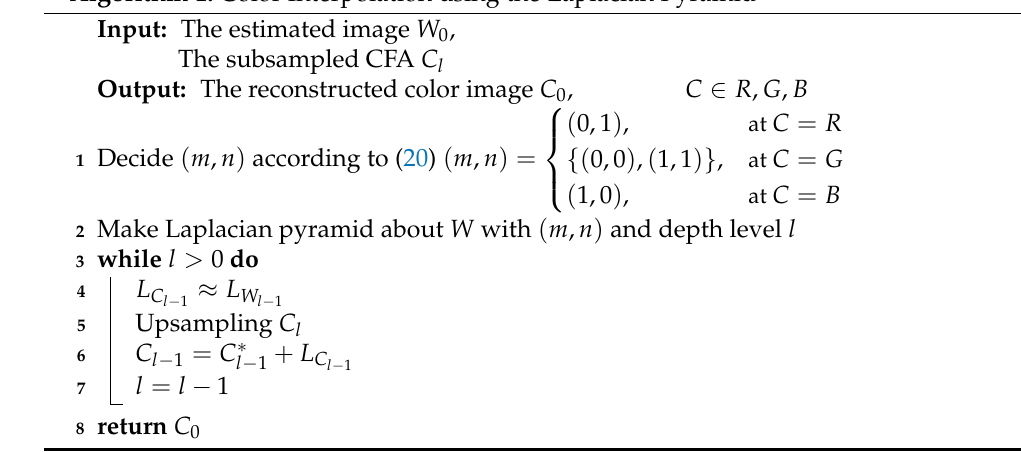
Algorithm 1: Color Interpolation using the Laplacian Pyramid